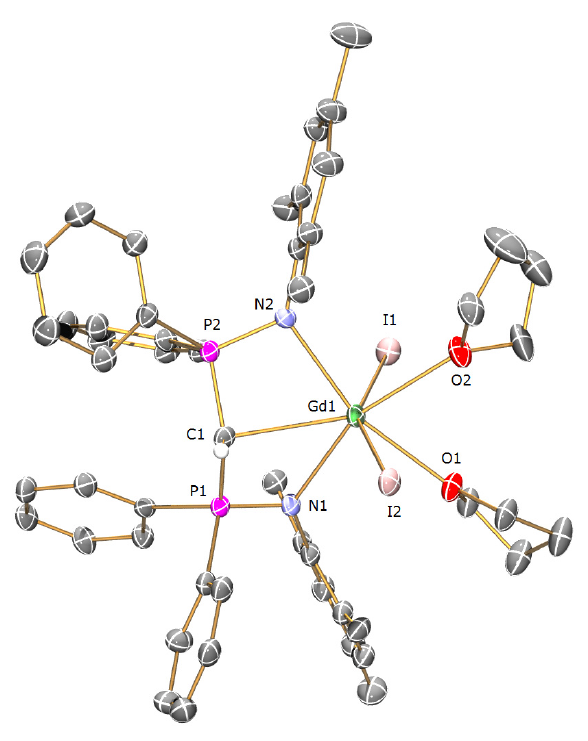
Figure 4. Molecular structure of 3 3C ellipsoids are drawn at 50% probability, with lattice solvent and non-methanide hydrogen atoms omitted for